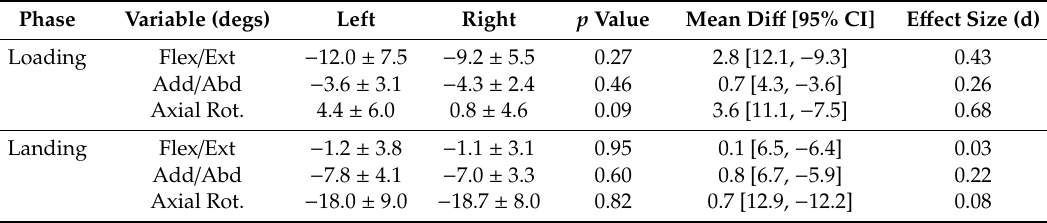
Table 3. Pelvis alignment for both loading and landing phases. Flex—Flexion; Ext—Extension; Add—Adduction; Abd—Abduction; Rot—Rotation.